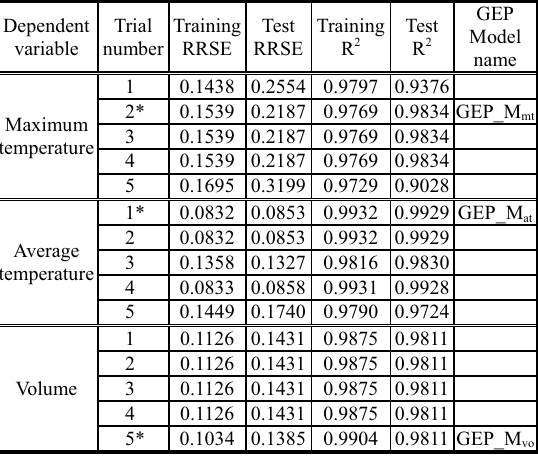
Table 6. Execution results of the GEP